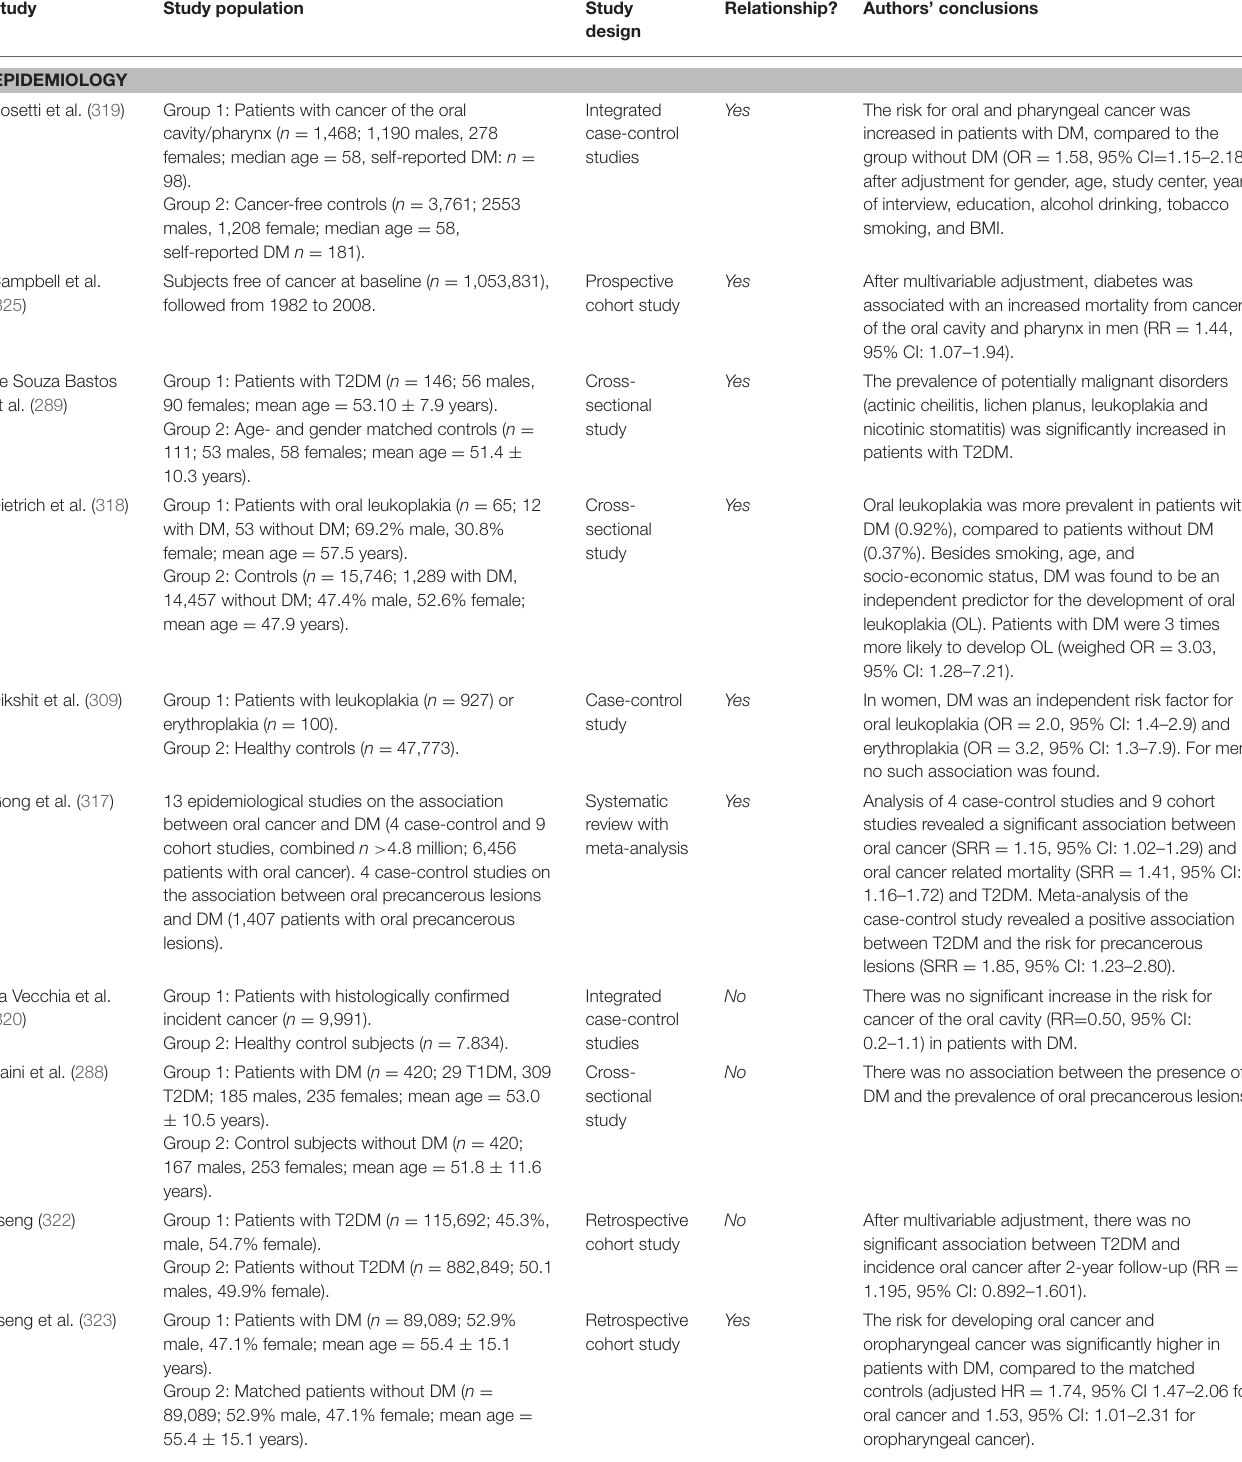
TABLE 6 | Overview of studies investigating the association between diabetes mellitus and oral cancer.